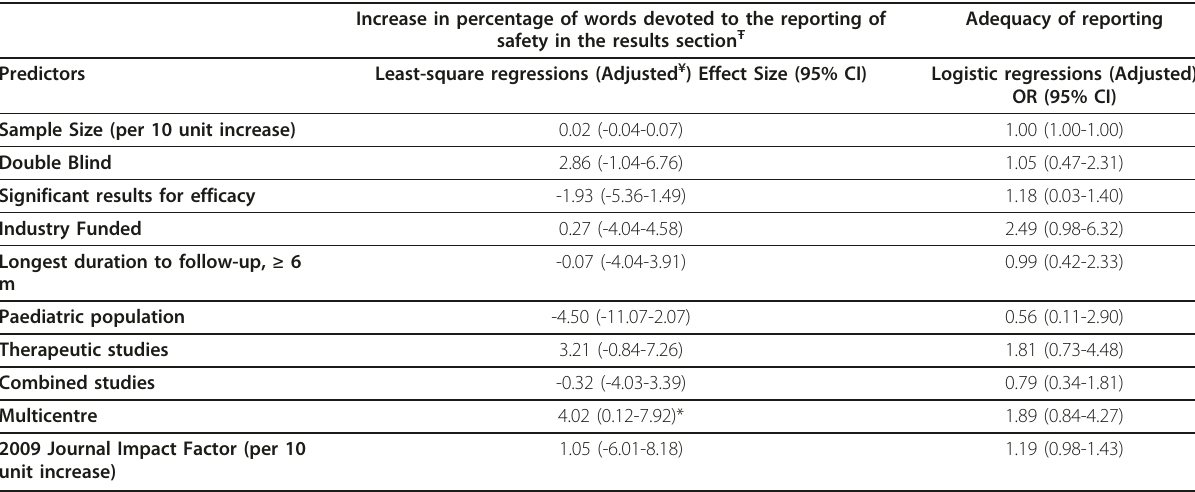
Table 5 Regression Analysis